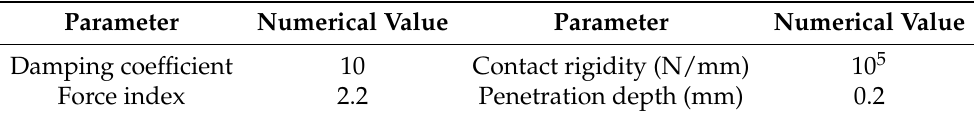
Table 1. Correlation coefficient between propping wheel and